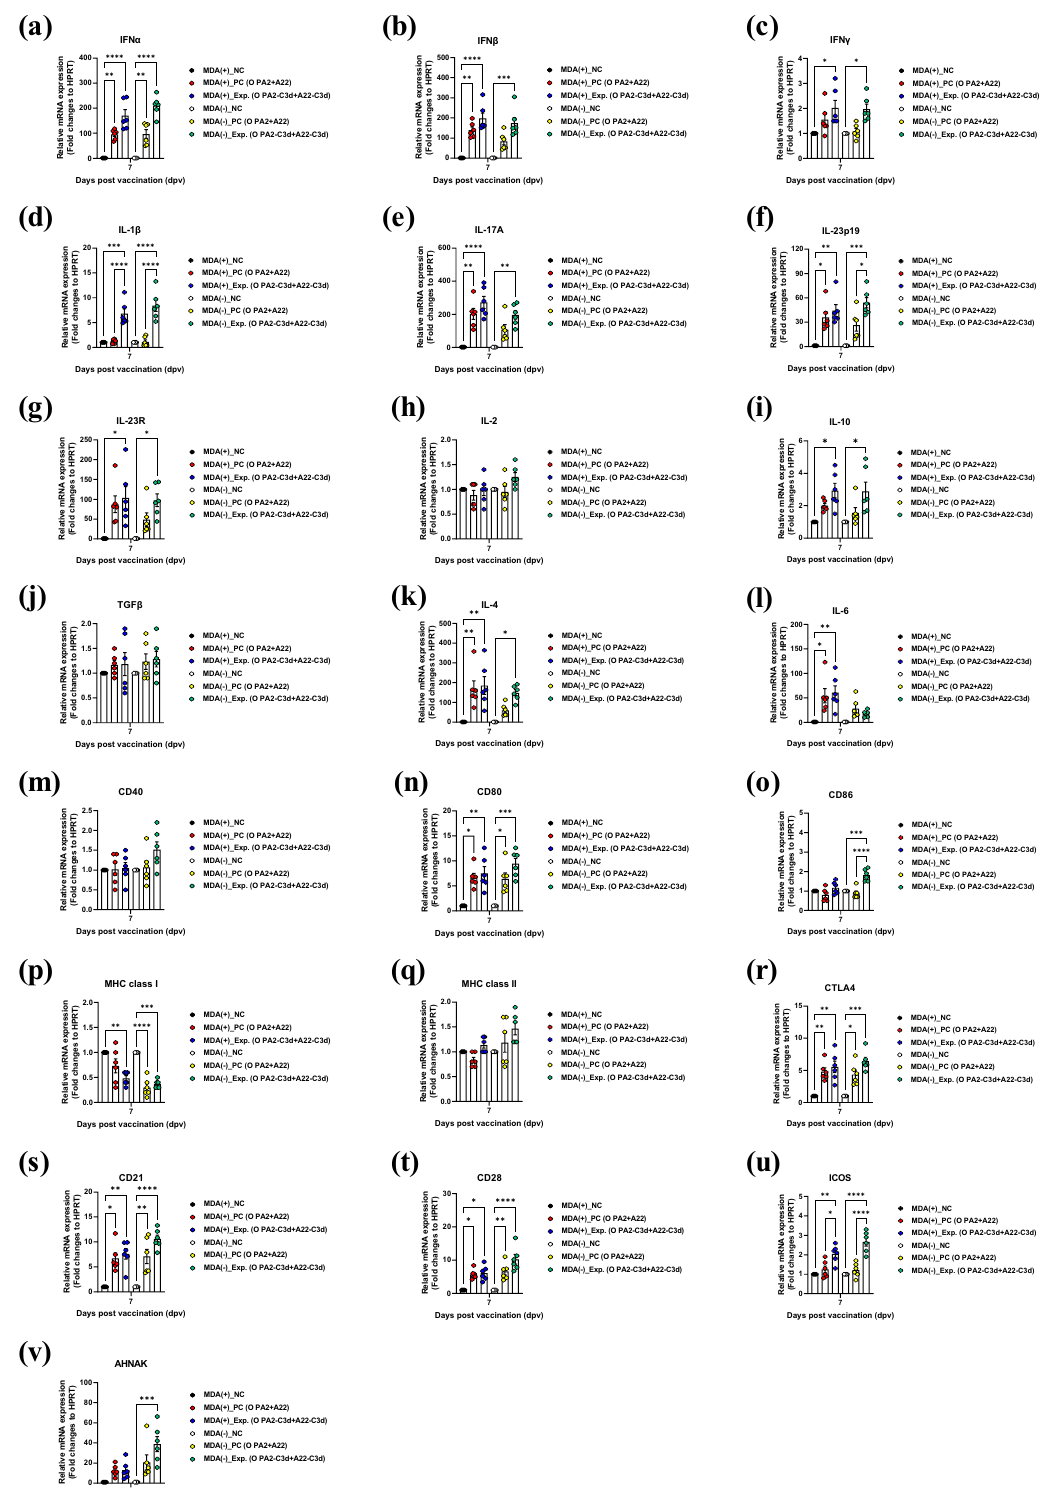
Fig. 7 O PA2-C3d and A22-C3d induced the gene expression of cytokine and co-stimulatory molecules in porcine peripheral blood mononuclear cells. Porcine peripheral blood mononuclear cells (PBMCs) isolated from the whole blood of vaccinated pigs ( n = 5/group) as described in Fig. 4a were used for qRT-PCR assays. Gene expression levels were normalized to HPRT levels and are presented as a relative ratio compared to control levels. ( a – v ) Gene expression levels of IFN α ( a ); IFN β ( b ); IFN γ ( c ); IL-1 β ( d ); IL-17A ( e ); IL-23p19 ( f ); IL-23R ( g ); IL-2 ( h ); IL-10 ( i ); TGF β ( j ); IL-4 ( k ); IL-6 ( l ); CD40 ( m ); CD80 ( n ); CD86 ( o ); MHC class I ( p ); MHC class II ( q ); CTLA4 ( r ); CD21 ( s ); CD28 ( t ); ICOS ( u ); AHNAK ( v ). Statistical analyses were performed using one-way ANOVA followed by Tukey ’ s test. * p < 0.05; ** p < 0.01; *** p < 0.001; and **** p <